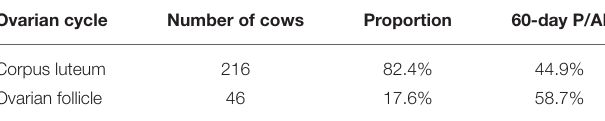
TABLE 6 | Cost of drugs, hormone, and frozen semen in M + C and Pre–OvSynch program during 180 DIM. Item